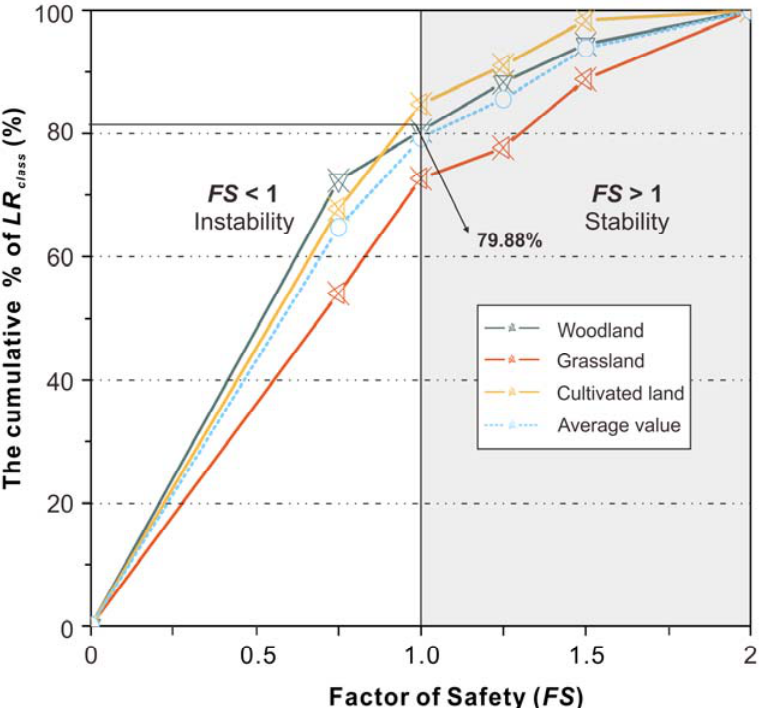
Figure 8. The visual representation of the cumulative LR class (%) at each factor of safety ( FS ) level.